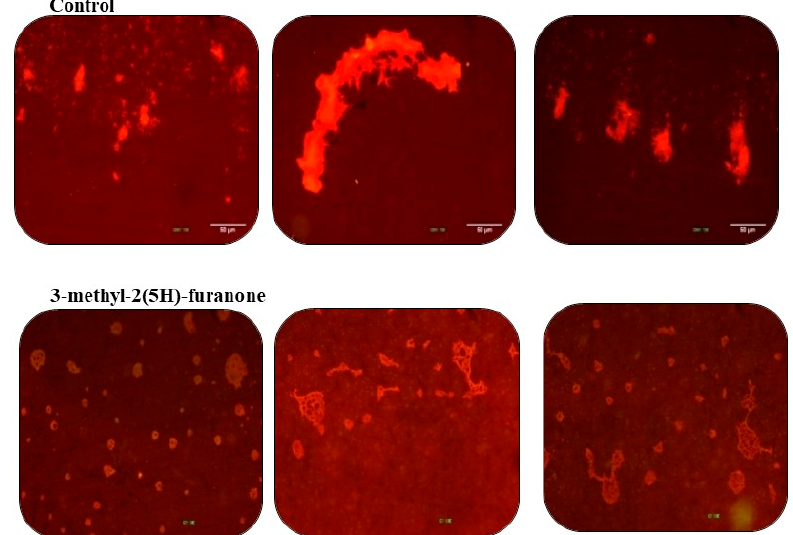
Figure 8. The biofilm of K. pneumoniae on coverslips. Upper: Biofilm formed for 30 h without treatment. Bottom: Biofilm formed under the effect of 3-methyl-2(5H)-furanone at 15 µg/mL . All biofilms were stained with acridine orange at 0.1% and observed with a fluorescence microscope with a blue filter.